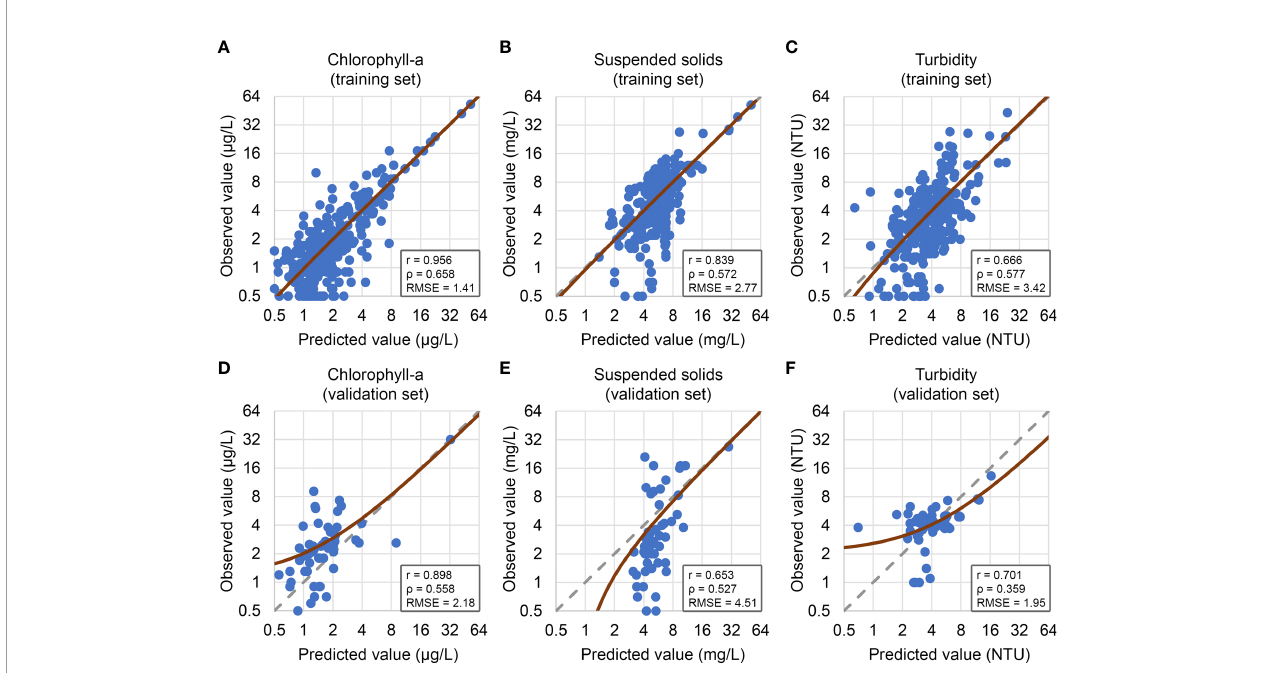
FIGURE 3 | Scatterplots comparing the predicted and observed values of chlorophyll-a, suspended solids and turbidity using the training set (A – C) and validation set (D – F) . The gray dotted lines indicate the one-to-one relationships and the red lines indicate the best- fi tting lines. Note that the x- and y-axes are in logarithmic scale, while the best- fi tting lines and all statistics are calculated based on the untransformed scale. Besides Pearson ’ s correlation coef fi cient (r) and root-mean- square error (RMSE), Spearman ’ s rank correlation ( r ) is also computed to provide a measure with lower sensitivity to outliers in the